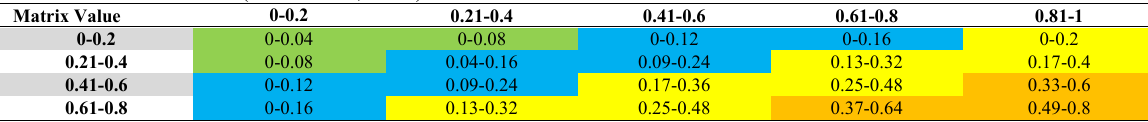
Risk Level Matrix Value (Chien et al.,